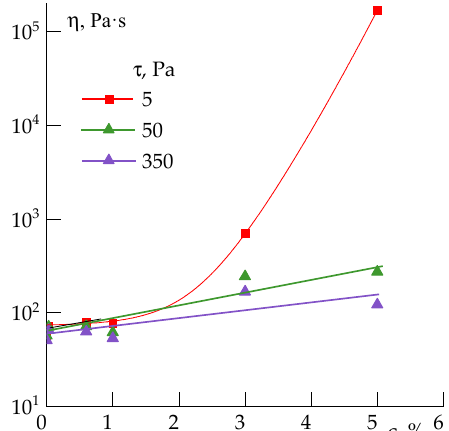
Table 2. Slopes’ values for 20 wt% PAN solutions filled silica. Silica concentration is at the solution weight.